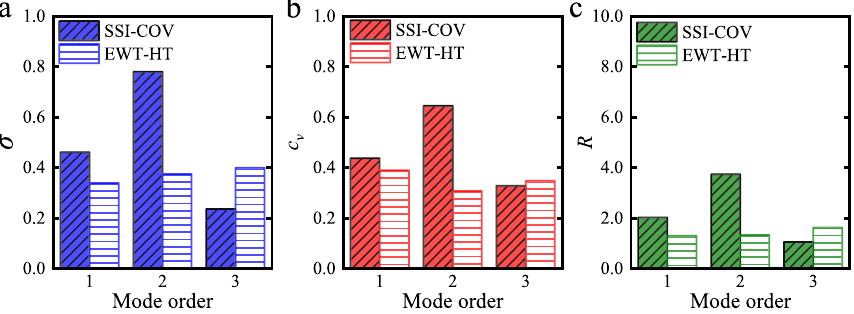
Fig. 19 Dispersion index of different methods at 20 m/s wind velocity: a Standard deviation σ ; b Coefficient of variation